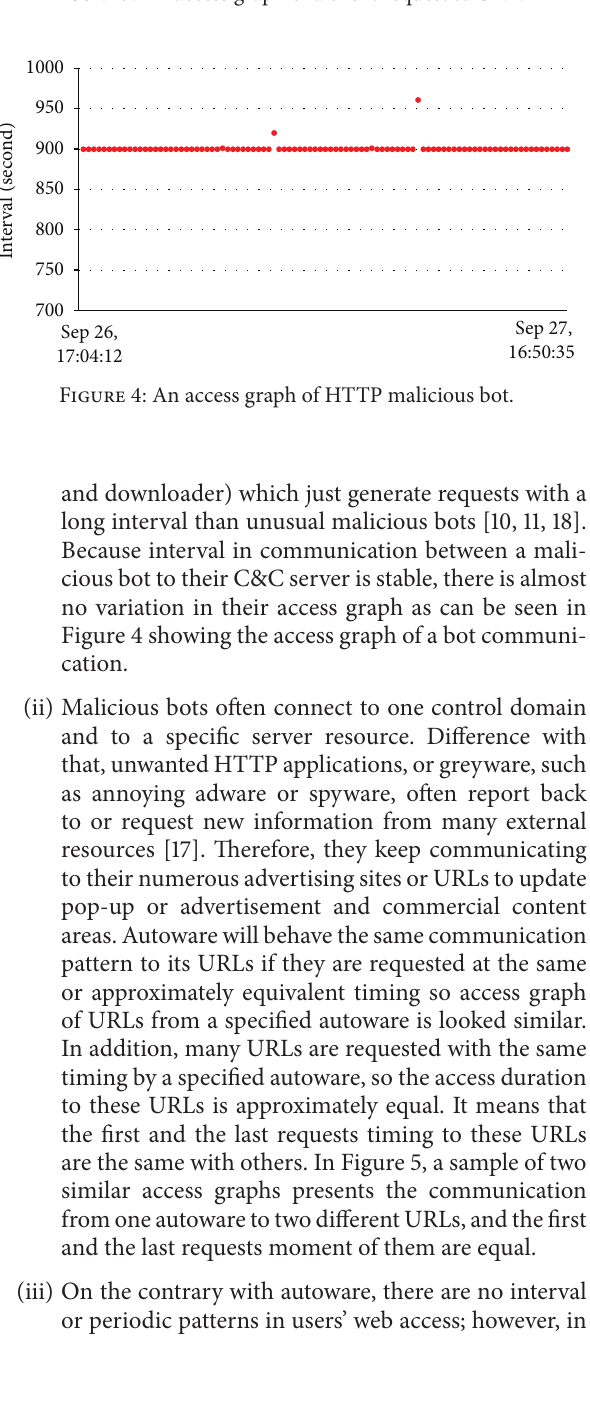
Figure 3: An access graph of a client request to URL.